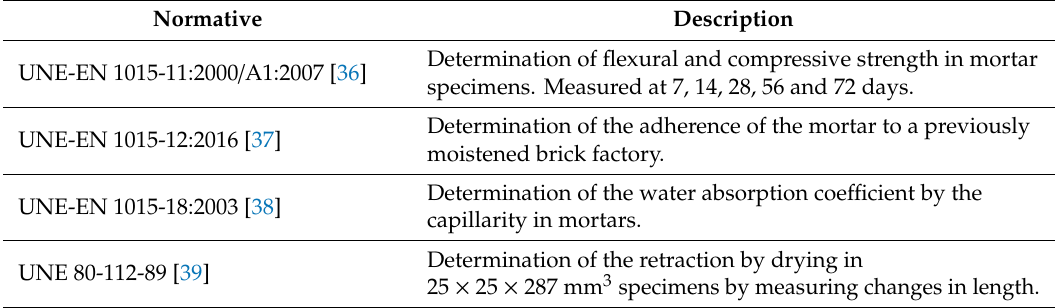
Table 1. Complementary tests for the determination of the mechanical properties in mortars.